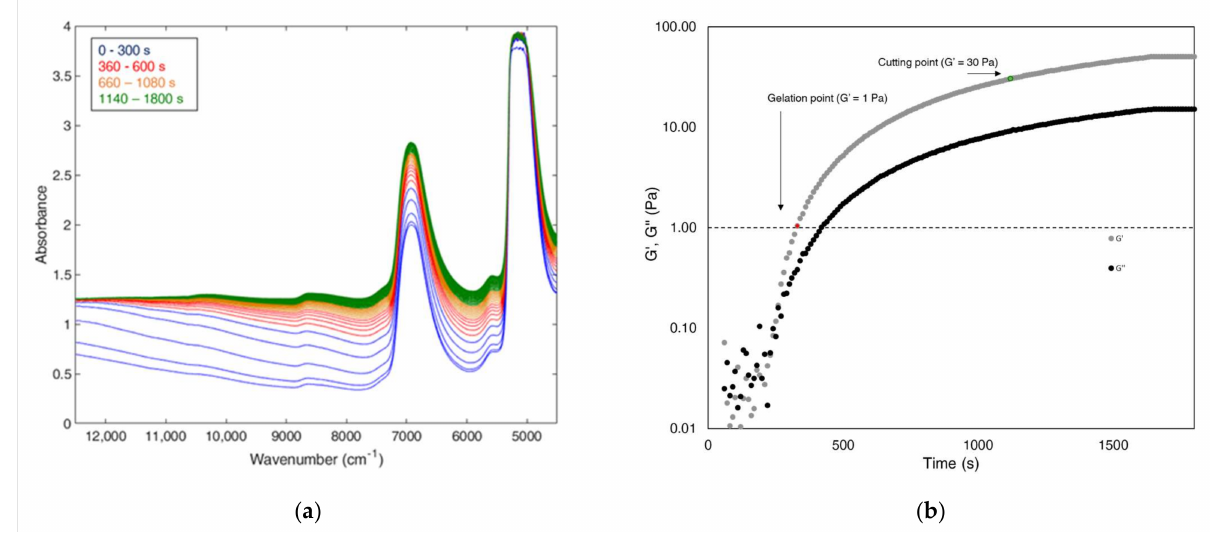
Figure 1. Line monitoring of the trial EPI60-R1: ( a ) FT-NIR spectra collected by the 64-scan procedure; ( b ) elastic (G (cid:48) ) and loss (G (cid:48)(cid:48) ) modulus curves obtained from the time–curing